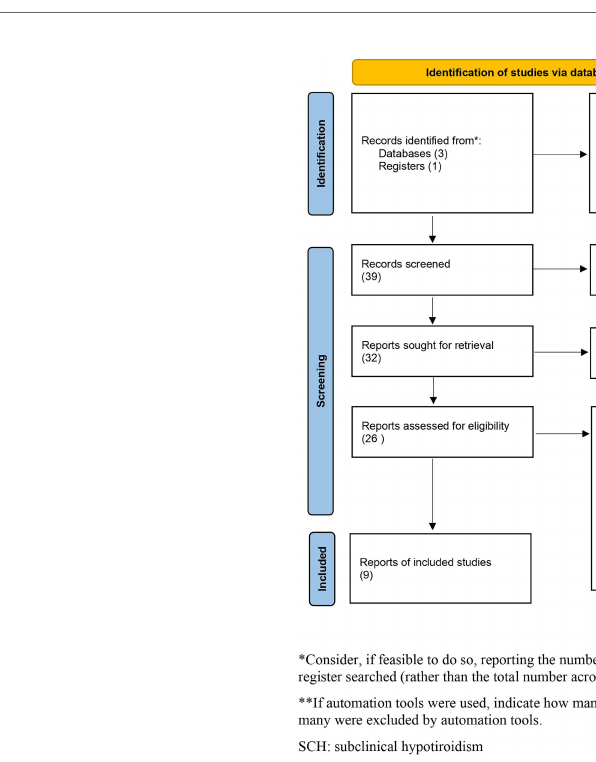
FIGURE 1 | Flow diagram of the systematic